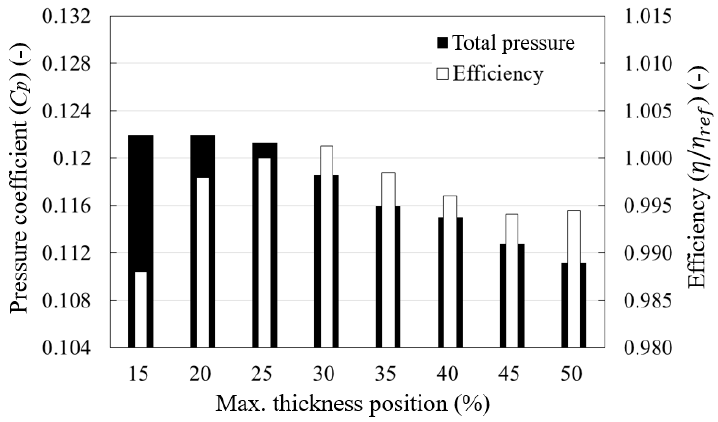
Figure 10. Performance with different maximum thickness positions ( 𝛷/𝛷 (cid:3031)(cid:3032)(cid:3046) = 1.0 ).